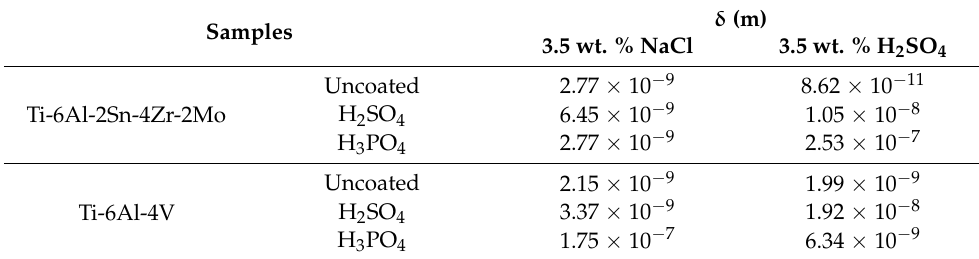
Table 4. Values of oxide film thickness generated by